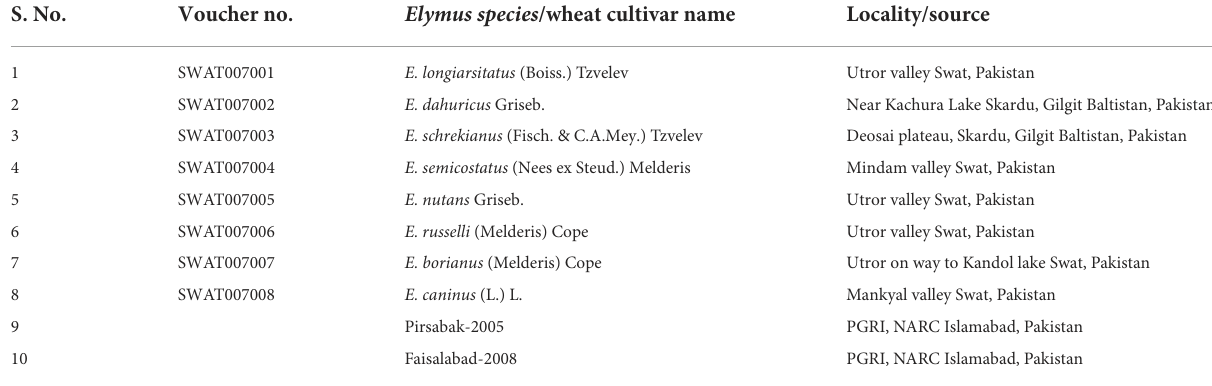
TABLE 1 Locality/source and voucher numbers of the studied Elymus species and wheat cultivars. S.